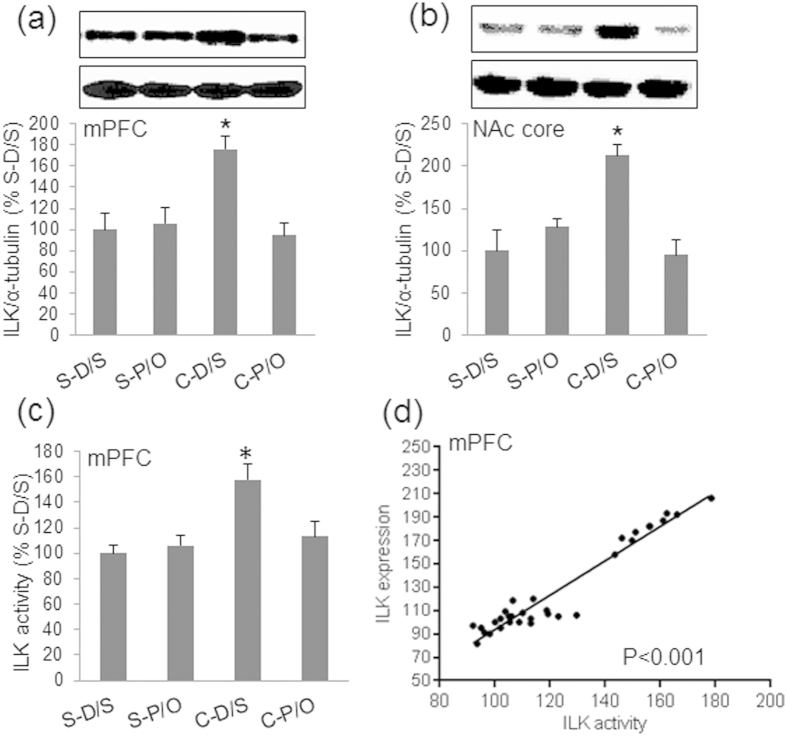
Pergolide/ondansetron treatment blocked changes in ILK expression following cocaine sensitization.(a) Percent densitometric values of integrin-linked kinase (ILK) protein levels in the mPFC in response to different treatment conditions; the top panel shows representative Western blots of ILK and α-tubulin proteins. Percent ILK protein levels are higher in the C-D/S groups than the other three groups. (b) Percent densitometric values of ILK levels in the NAc core; representative Western blots are shown in the top panel. Percent ILK protein contents are higher in the C-D/S group than in all other groups. See Figure 1 for details of the groups. *p < 0.05 C-D/S from all groups. (c) ILK activity and (d) correlation between ILK expression and ILK activity in the mPFC in saline-injected and cocaine-sensitized rats. Cocaine sensitization-induced increase in ILK activity correlated with increases in ILK expression. *p < 0.05, C-D/S versus all groups.